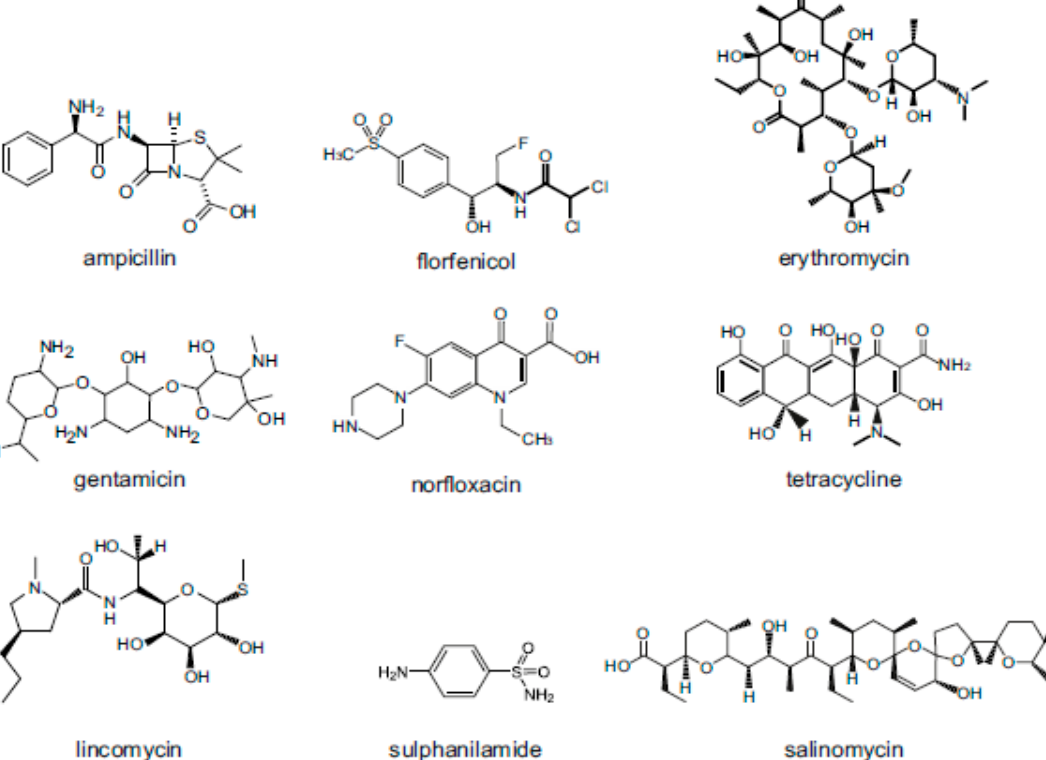
Figure 2. Structures of representative compounds from each class of antimicrobials used as veterinary drugs.